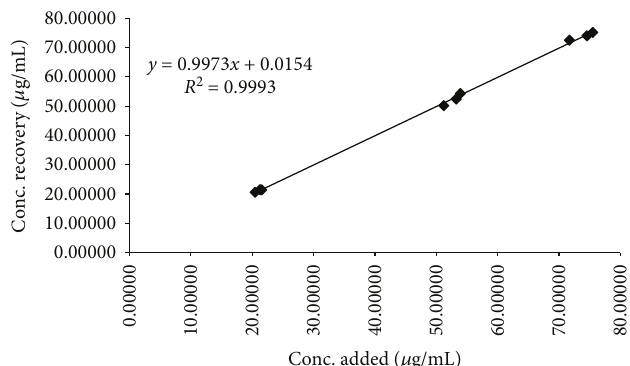
Figure 10: Accuracy for ketorolac in the degradation products.